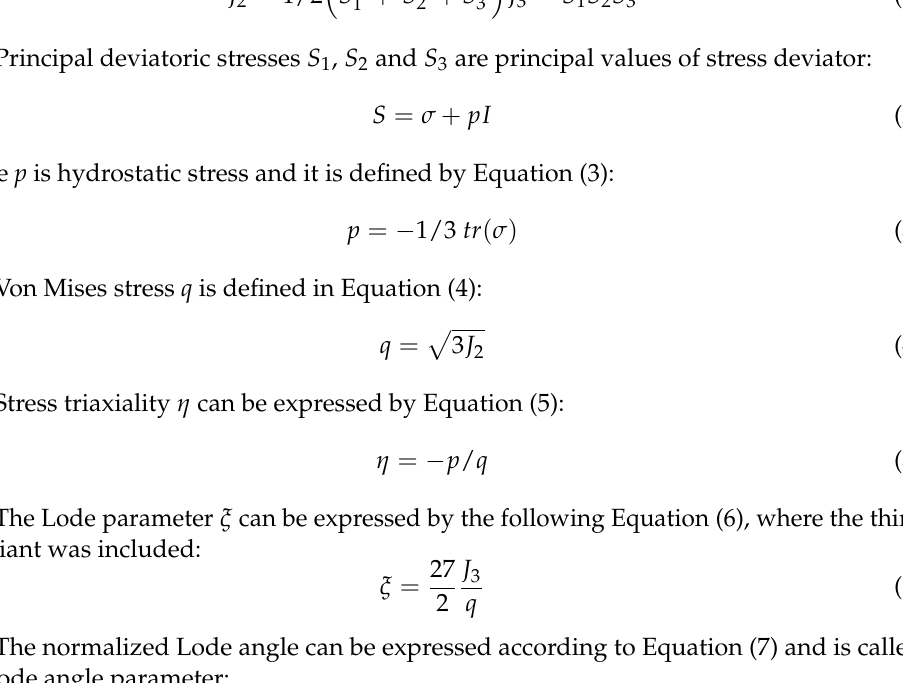
Figure 8. ( a ) Results of hardness measurement—HV1 distribution of hardness with measurement step of 1 mm along three directions, ( b ) schema of honeycomb structure with the directions of measurement ZXY, YZX and XYZ presented.